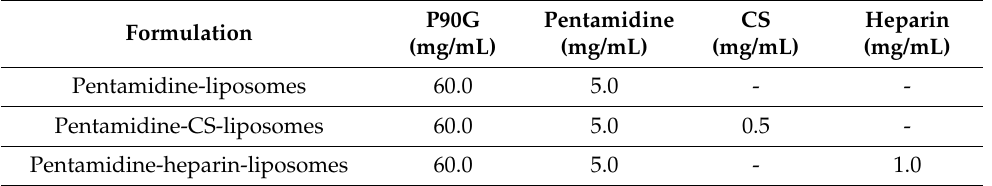
Table 1. Composition of liposomes encapsulating